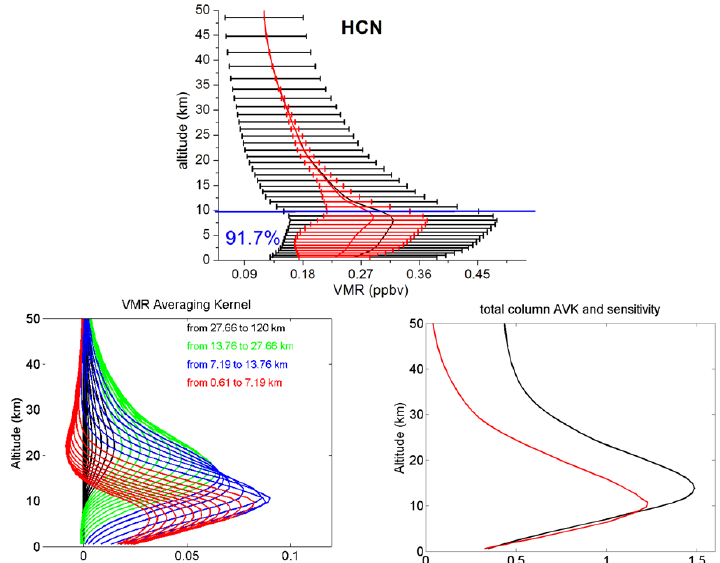
Figure 4. Same as Fig. 3 but for